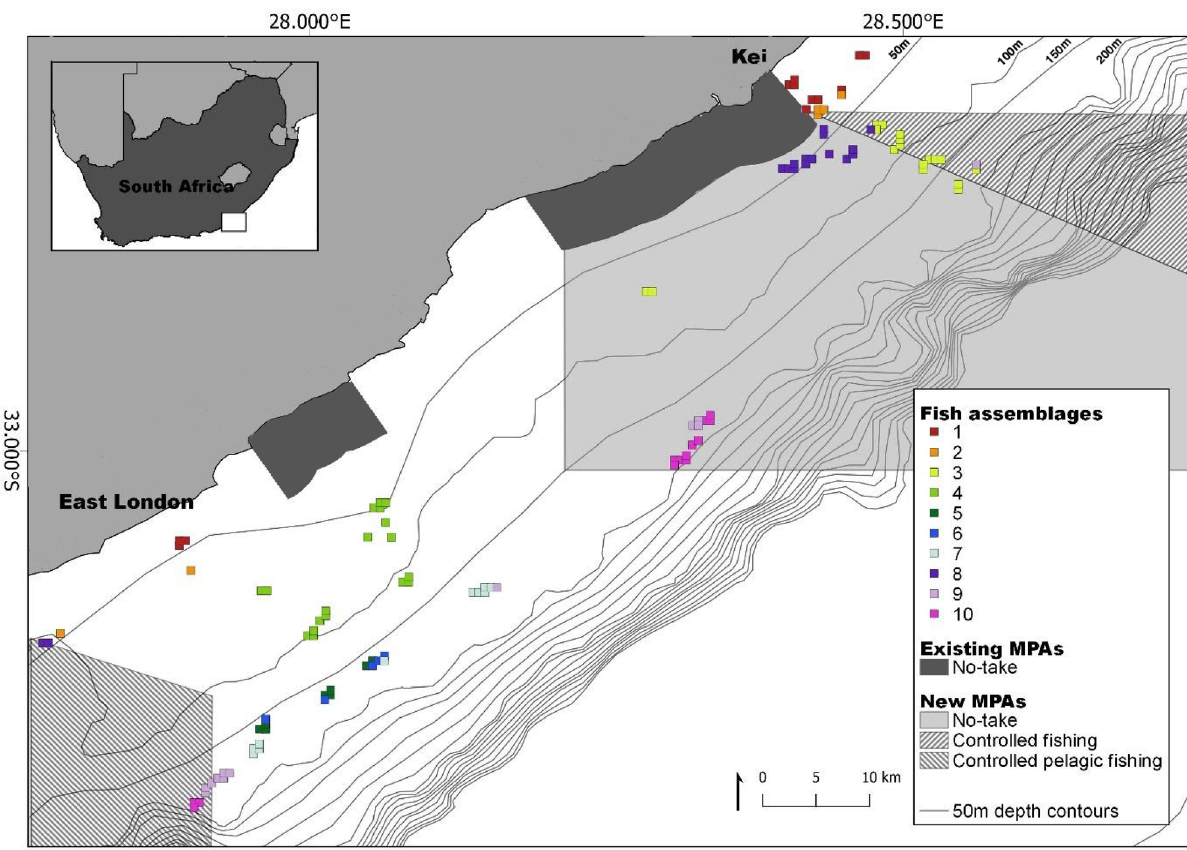
Figure 4. Spatial distributions of the fish assemblages on the Amathole continental shelf, located on the south coast of South Africa. Fish assemblages are clusters of species determined using a Multivariate Regression Tree that includes depth, substrate clusters, distance from shore and the two broad areas of East London and Kei. These fish assemblages are labelled 1 to 10. The 50 m bathymetric contours as well as existing and new Marine Protected Areas (MPAs) are indicated. The existing MPAs were declared as official reserves in 1984 and later proclaimed as MPAs in 2011 and the new MPAs were proclaimed in 2019. The MPAs are divided into zones with different restrictions namely (1) no-take, (2) controlled fishing, where extraction and harvesting of marine life are allowed with restrictions and limitations, and (3) controlled pelagic fishing, where only pelagic linefishing of specific species may occur. Map created in QGIS ver. 3.8 56 using shapefiles provided by the South African National Biodiversity Institute 64 and fish assemblages generated in R statistical software 59 (CRAN ver.